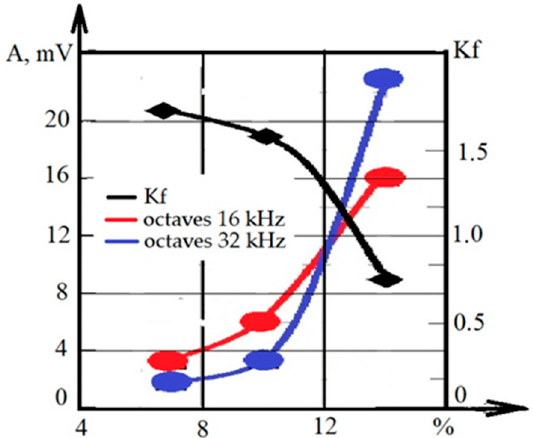
Figure 26. RMS amplitude changes in the octaves of 16, 32 kHz, and K f coefficient with the proportion of intermetallic compounds.